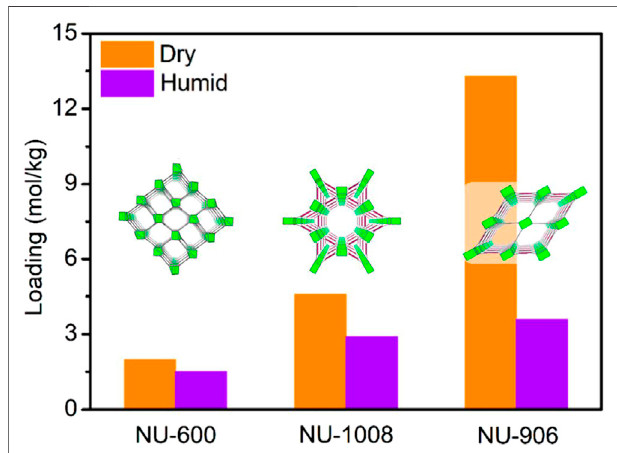
FIGURE 2 | 2-chloroethyl ethylsul fi de (2-CEES) loading of three zirconium-based MOFs under dry (0% RH) and humid (80% RH) conditions. Adapted from Chen et al. (2020) with permission from the American Chemical